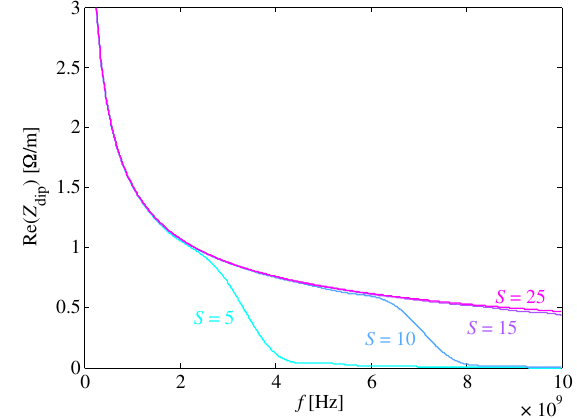
FIG. 2. Convergence of mode matching as a function of the number of longitudinal modes S . Mode matching